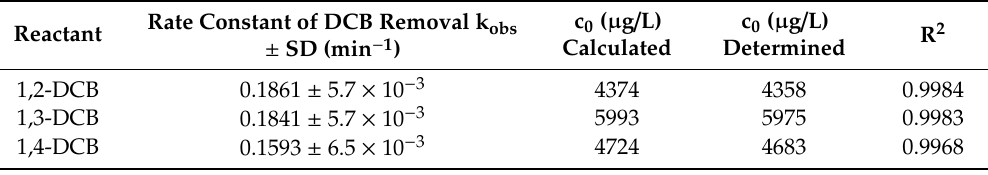
Table 4. Observed rate constants for removal of dichlorobenzenes (DCBs) via HDC described in Figure 5, using the Raney Al-Ni alloy, evaluated based on a non-linear regression analysis (fitted to the first order model).